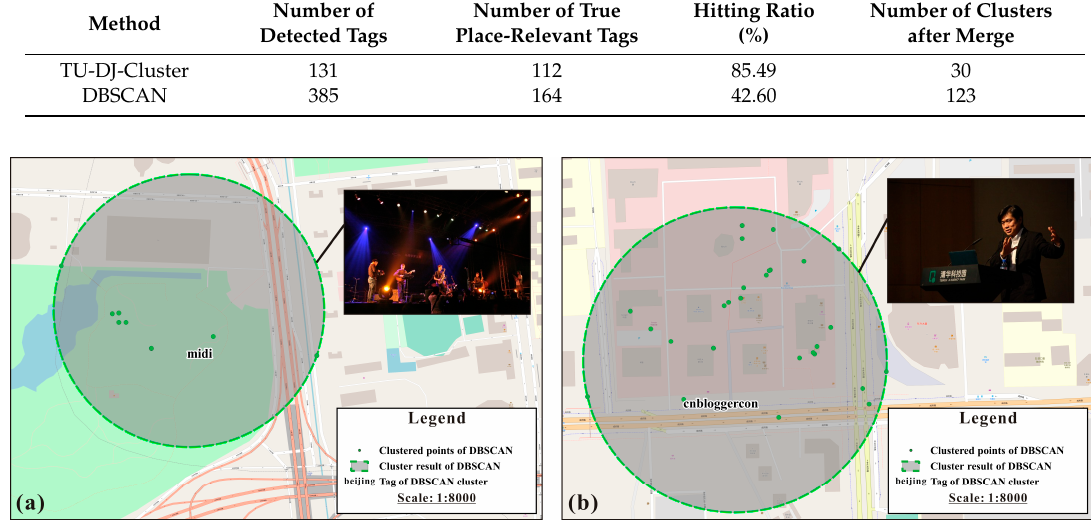
Table 2. Place-relevant tag detection results of two methods.